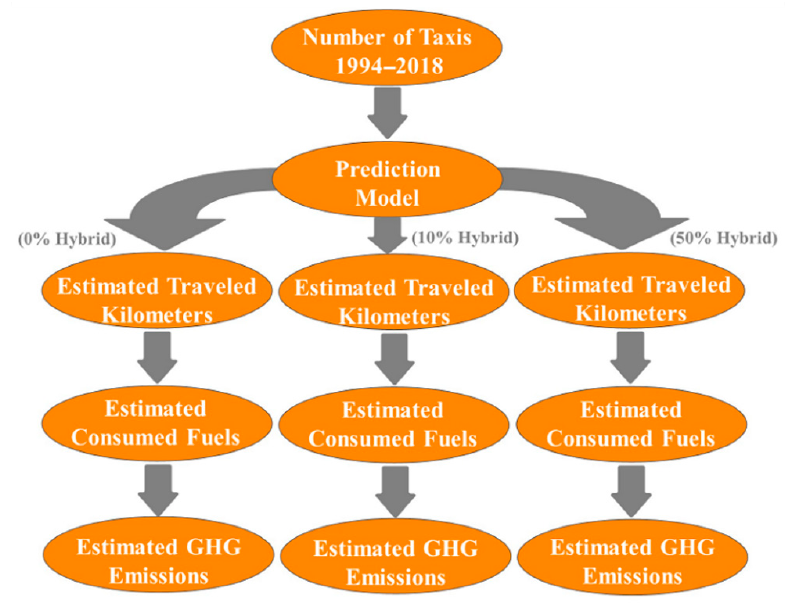
Figure 1. Implemented methodology